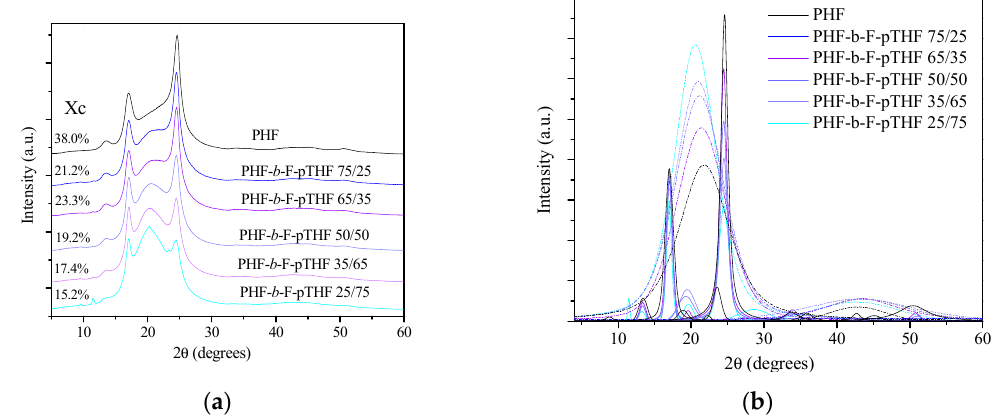
Figure 6. X-ray diffraction (XRD) curves of PHF- b -F-pTHF copolymers ( a ) with separated crystalline peak positions and amorphous halo reflections ( b ).